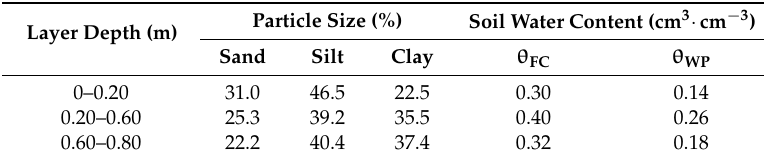
Table 1. Main soil physical and hydraulic properties of the experimental site, Paysandú.